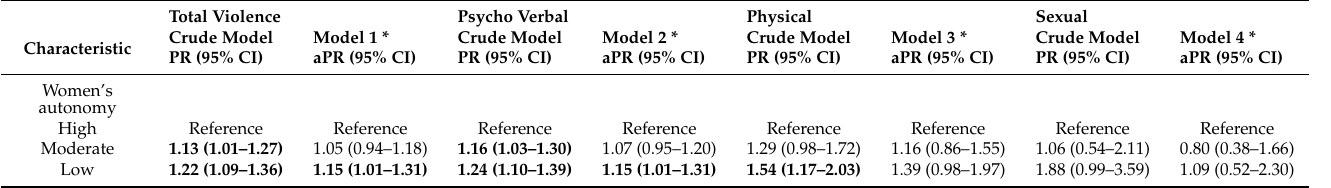
Table 5. Association between women’s autonomy and intimate partner violence in the last 12